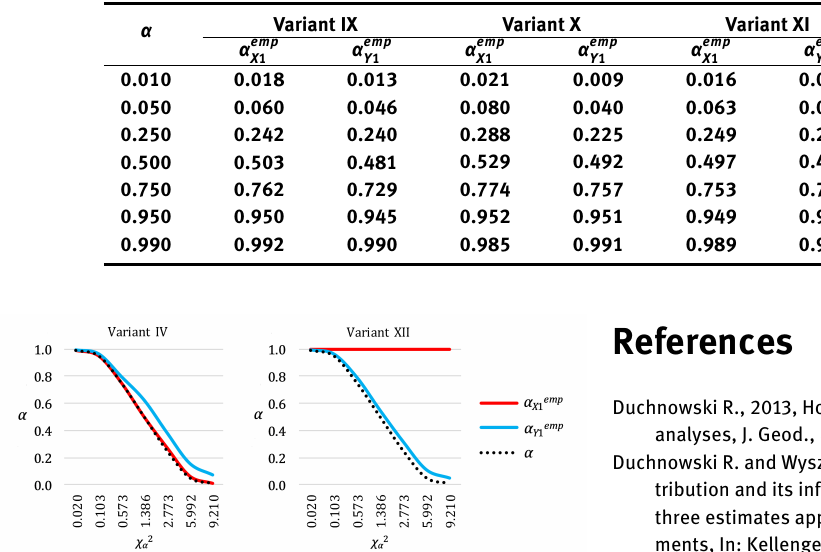
and α emp for HLWEs in horizontal network X 1 Y 1